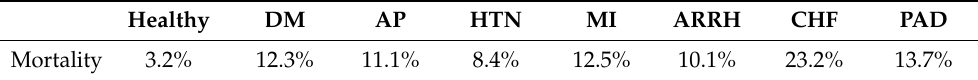
Table 4. Three-year mortality in the cardiovascular diseases and diabetes groups. Healthy DM AP HTN MI ARRH CHF PAD Mortality 3.2% 12.3% 11.1% 8.4% 12.5% 10.1% 23.2% 13.7%